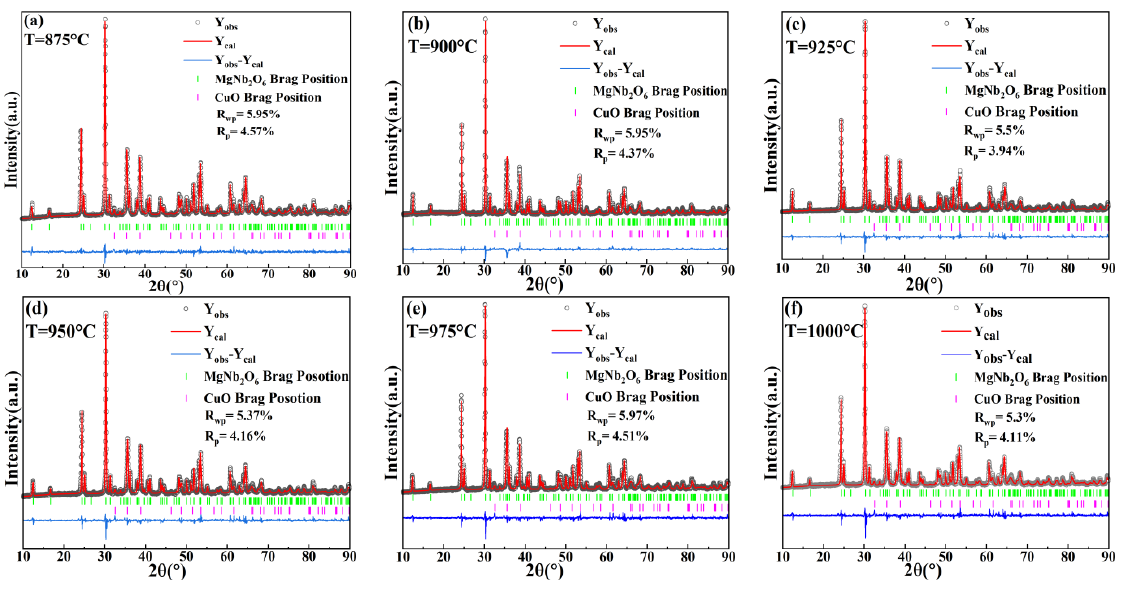
Figure 3. Rietveld refinement patterns of MgCu 2 Nb 2 O 8 ceramics sintered at several temperatures from 875 °C to 1000 °C.